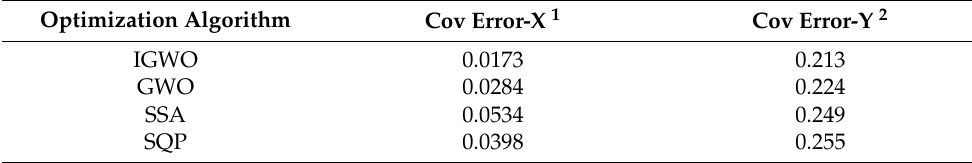
Table 3. Table of tracking error covariance in each direction of